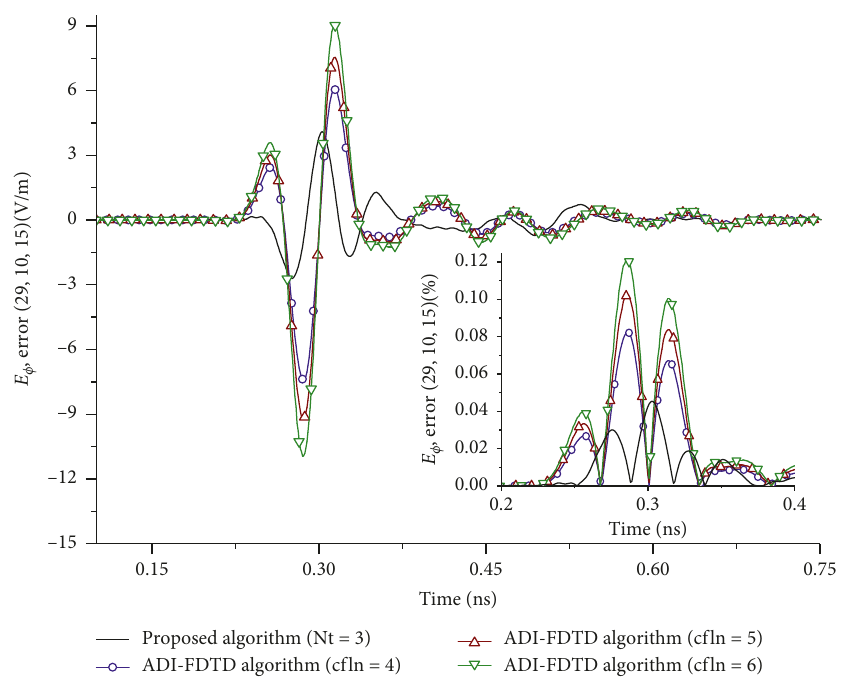
Figure 15: Errors obtained by E